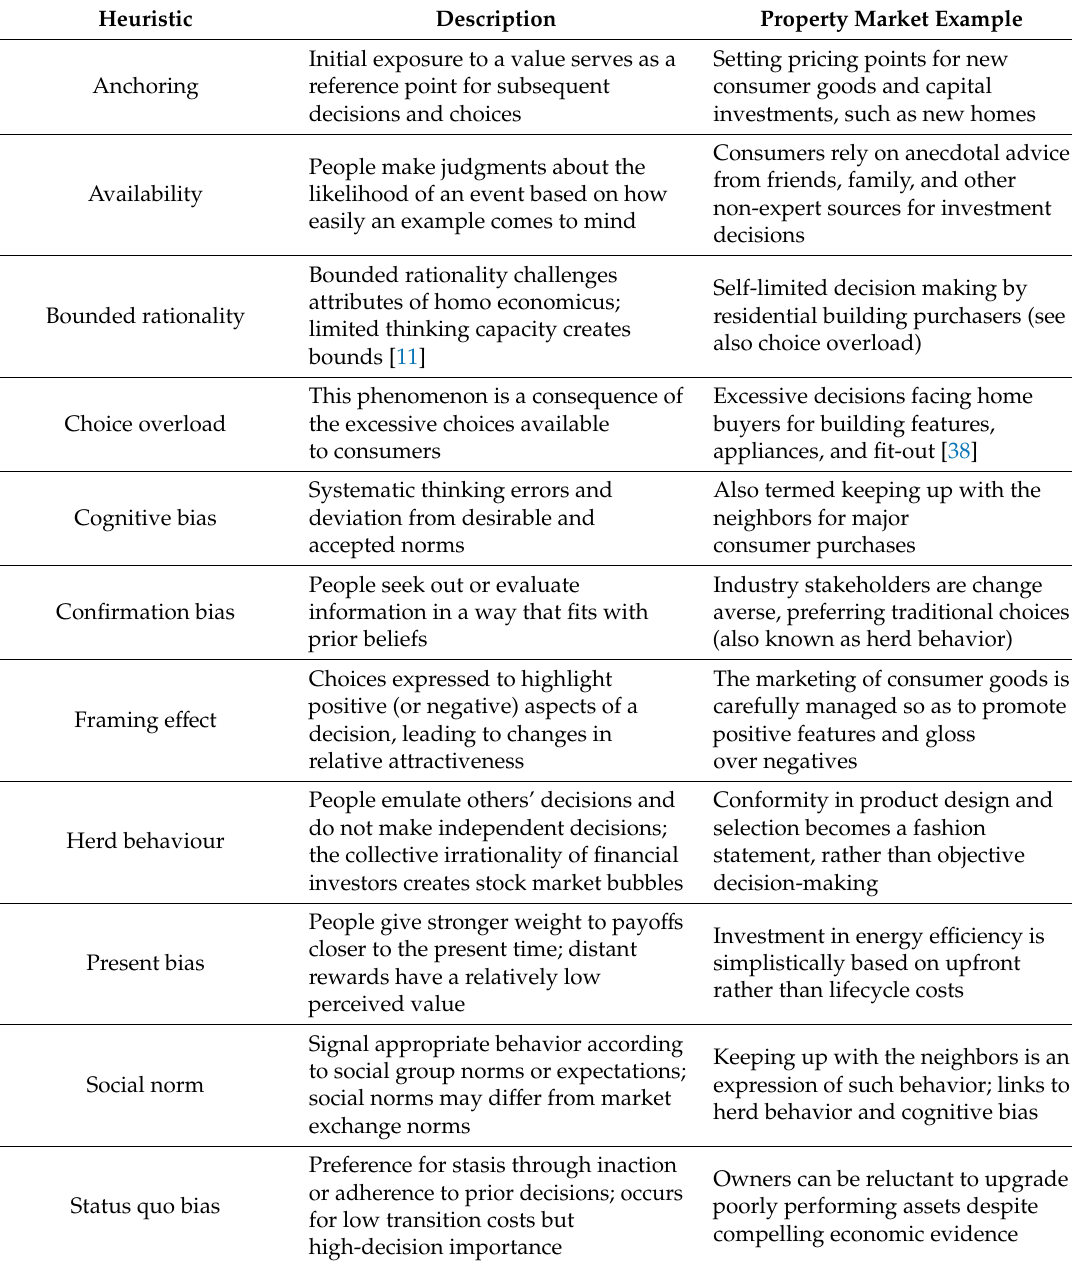
Table 2. Heuristics developed under BE theory: applicability to property market